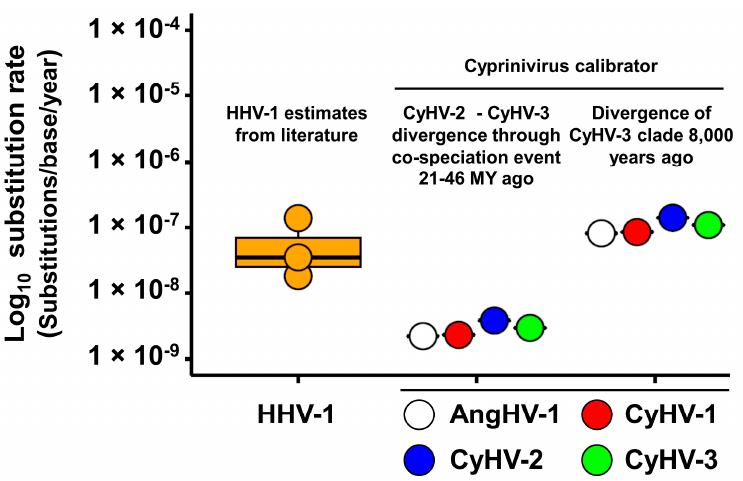
1 Corresponding time trees are presented in Figure S3. 2 These represent changes along branches leading to each species clade (or single lineage in the case of CyHV-1) and thus represent species-specific substitution rates; i.e., the rates at which mutations became fixed in populations prior to species clade divergence.